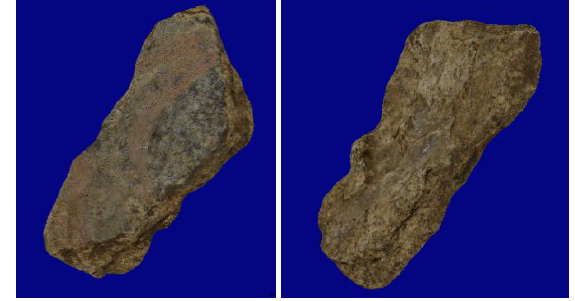
Figure 7: 3D point cloud of the artefact